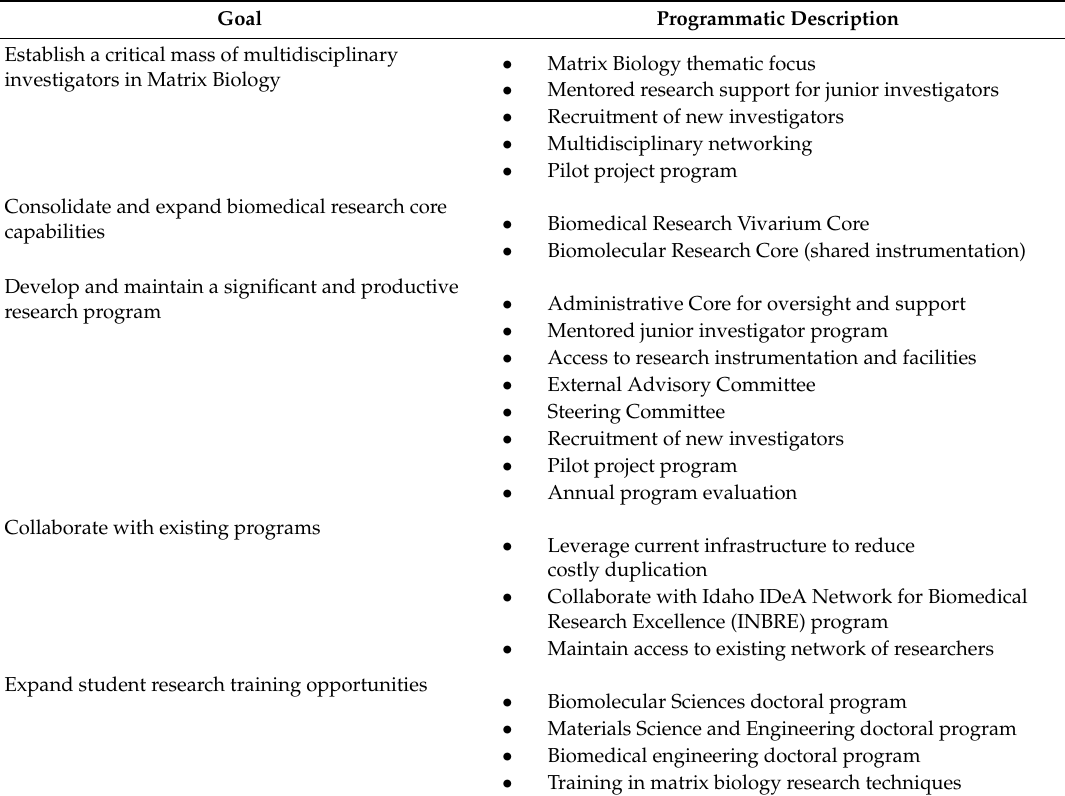
Table 1. Specific goals of the Center of Biomedical Research Excellence in Matrix Biology. Goal Programmatic